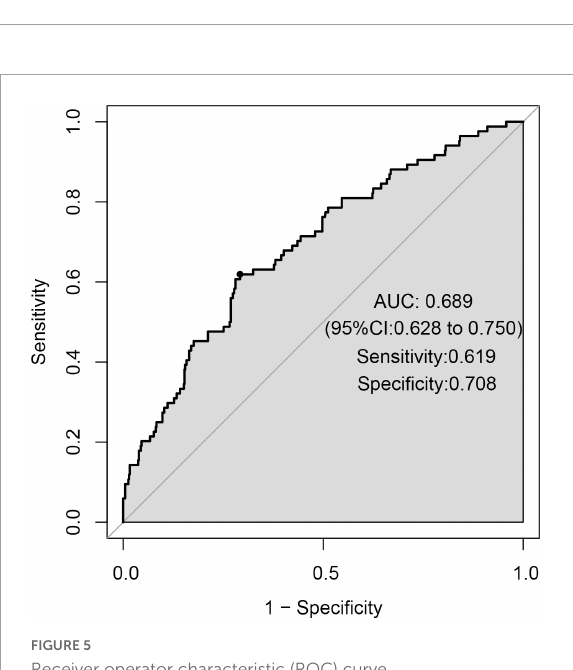
FIGURE5 Receiver operator characteristic (ROC)